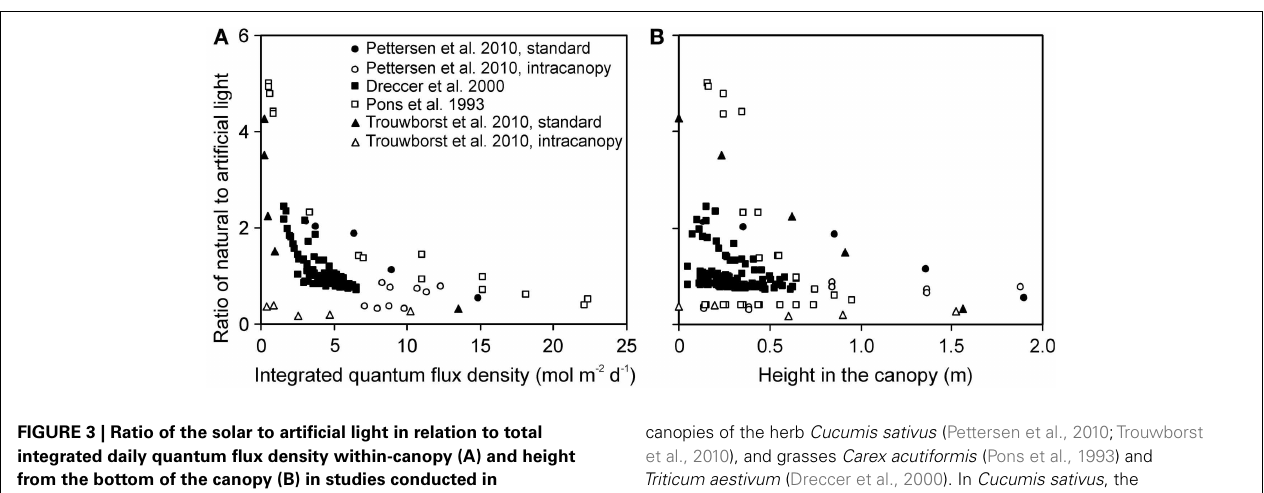
FIGURE 3 | Ratio of the solar to artificial light in relation to total integrated daily quantum flux density within-canopy (A) and height from the bottom of the canopy (B) in studies conducted in greenhouses with supplemental lighting. The share of natural and artificial light was determined as described in Material and methods (see Estimation of Changes in Light Profiles for Studies with Combined Natural and Supplemental Lighting).The studies were conducted in the